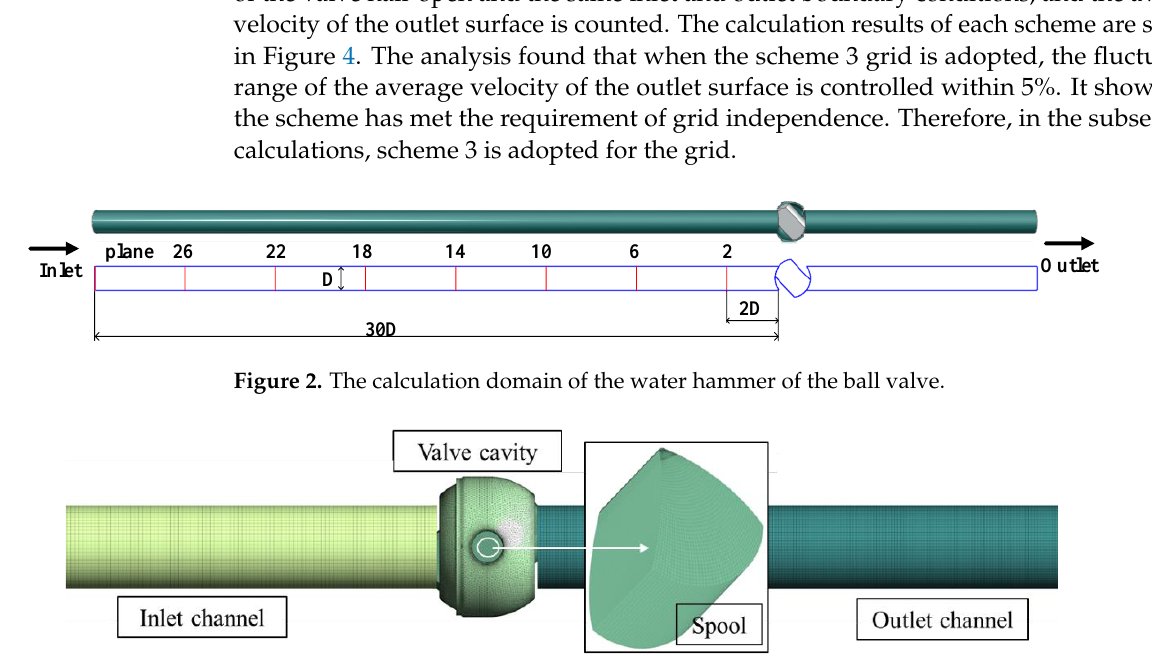
Figure 3. Ball valve fluid domain grid and partial enlarged view.